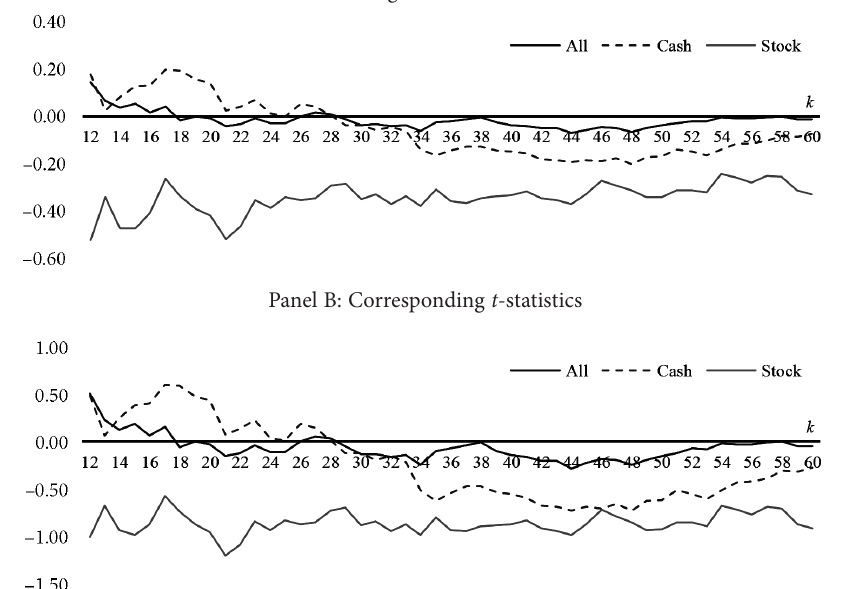
Figure 1. Results of the cross-sectional